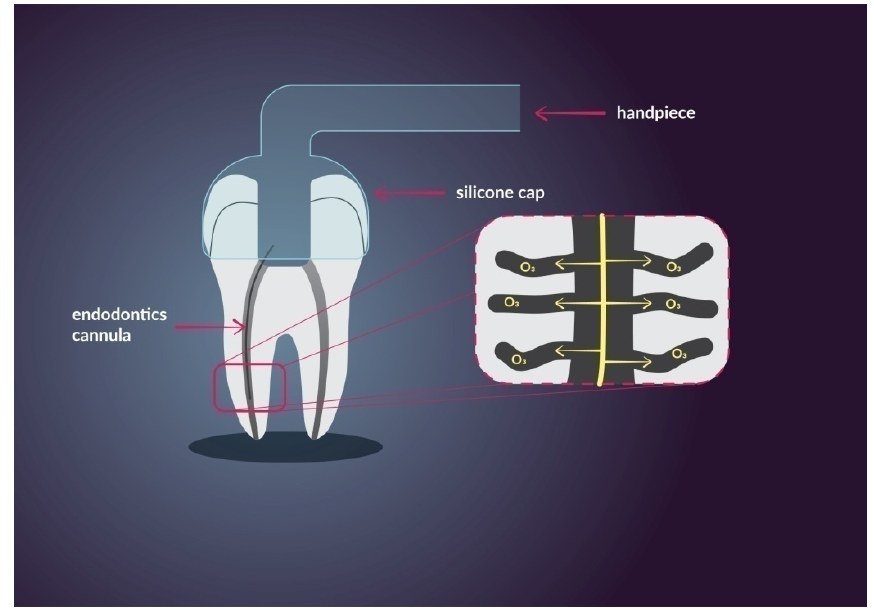
Figure 3. Aschemeof application of ozone treatment.